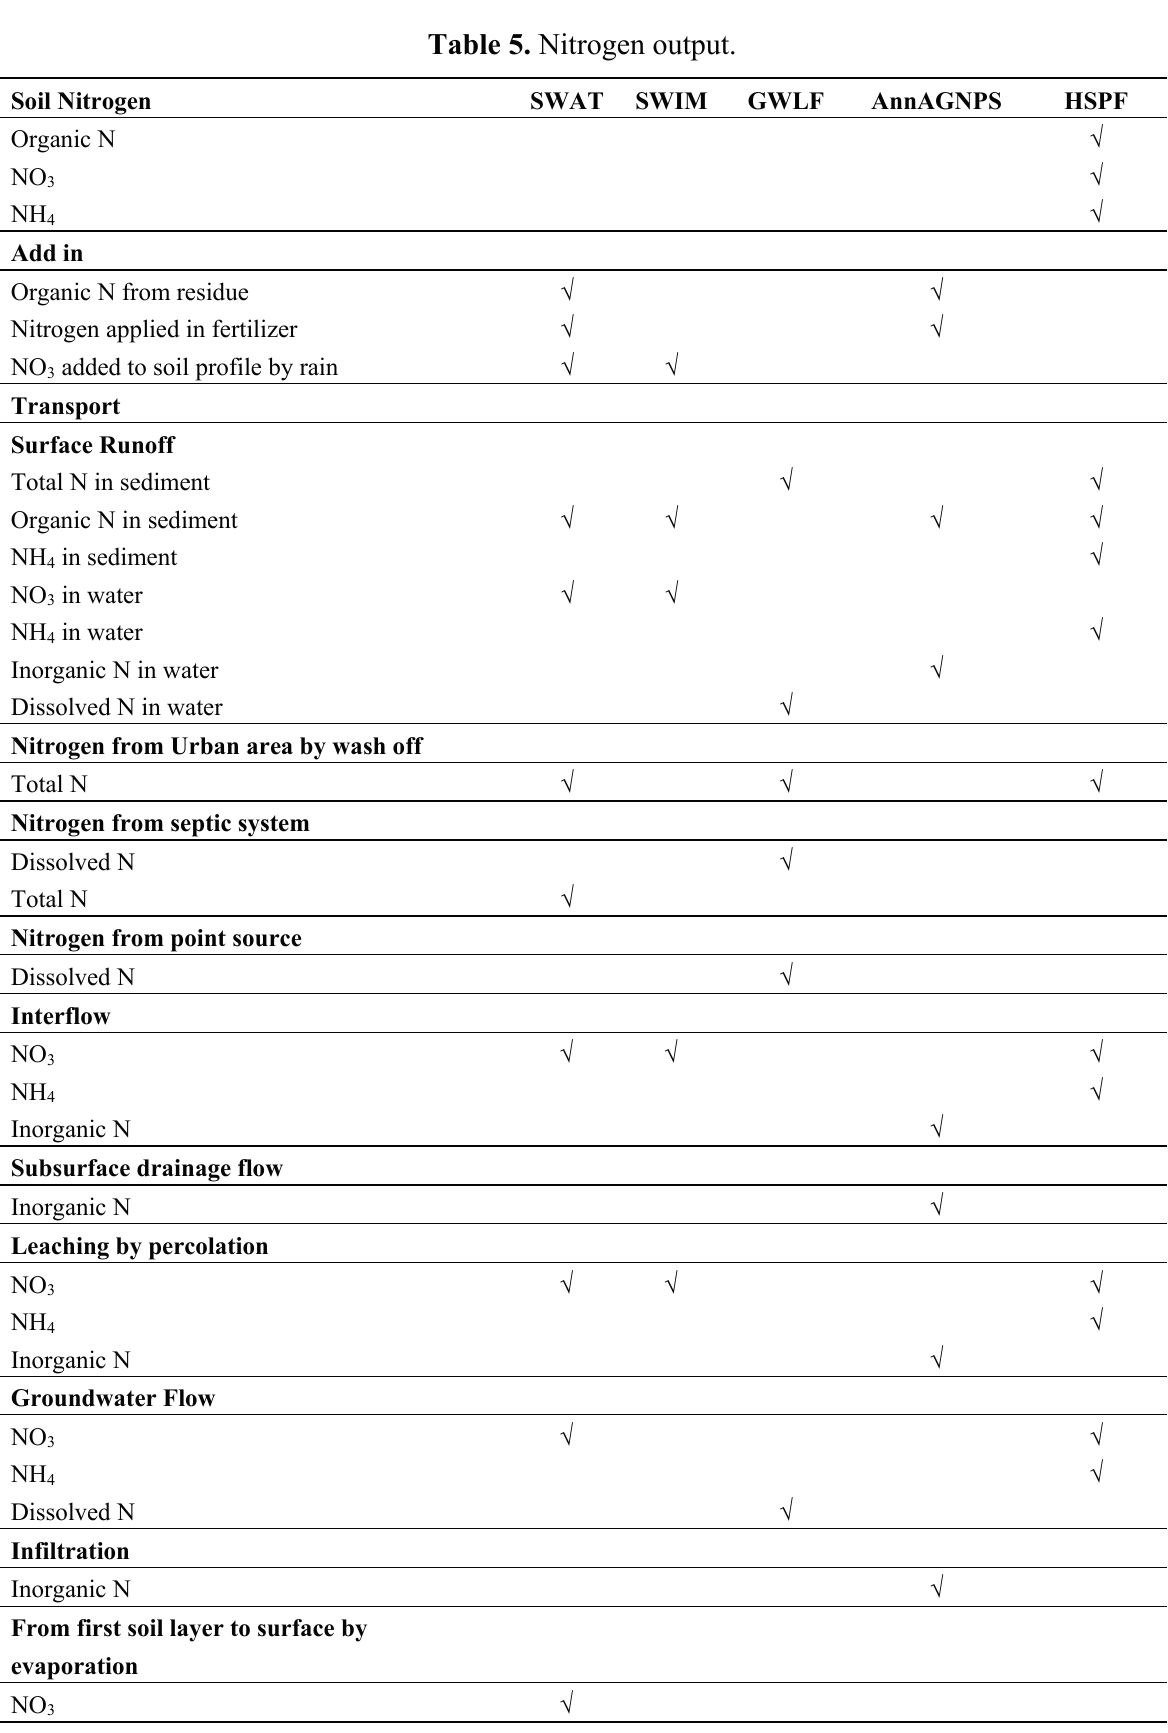
Table 5. Nitrogen